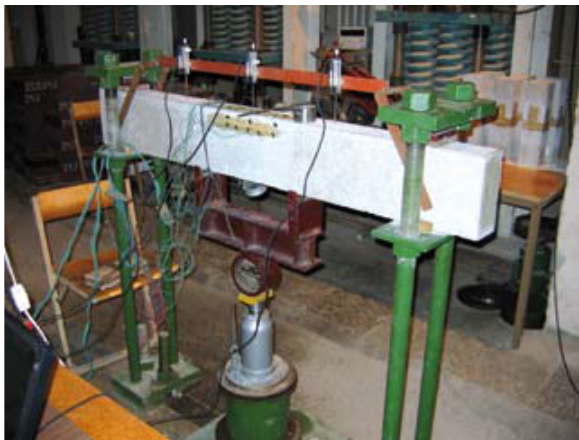
Fig. 5. Overview of test set up